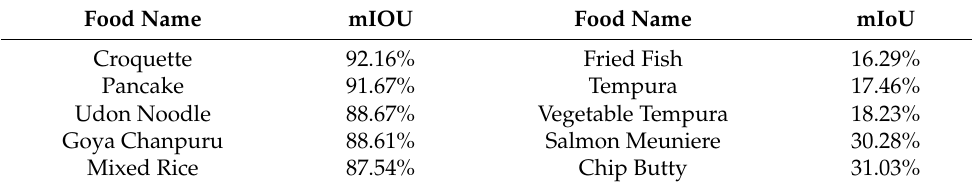
Figure 7. Sample images, ground truth masks and corresponding predictions from the UEC Food- Pix dataset. Table 5. Comparison and analysis of food segmentation performance class-wise for the UEC FoodPix dataset. The left section mentions classes with the highest mIOU while the right section mentions the classes with the lowest